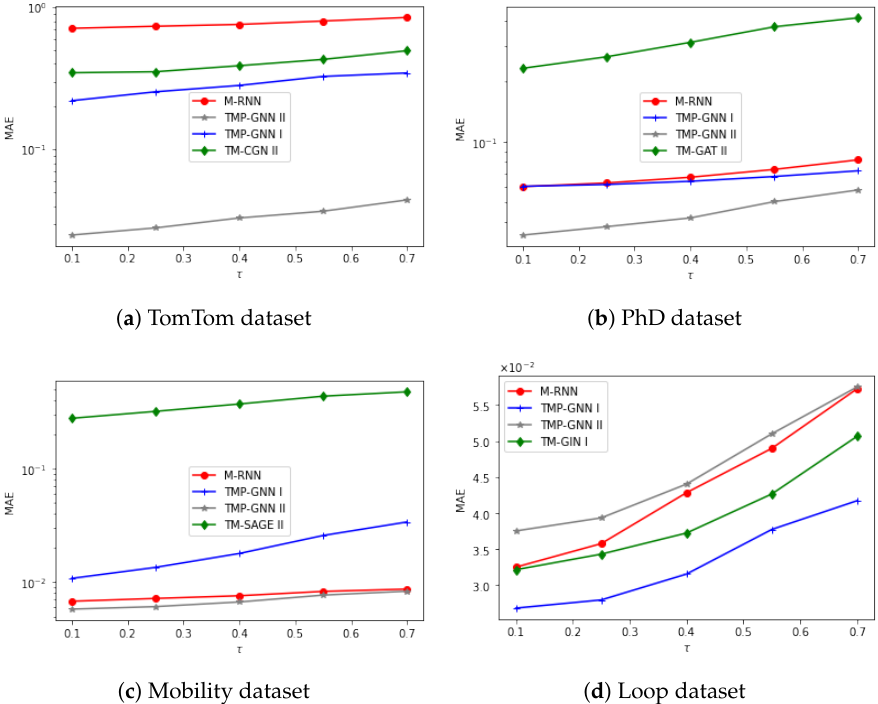
Figure 11. Performance evaluation of E-TMP-GNN I and II on missing data estimation vs. M-RNN and counterpart